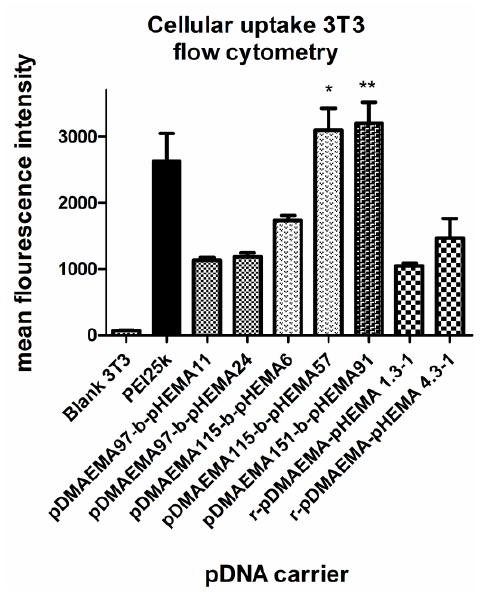
Figure 12. Cellular uptake of copolymer DNA-complexes with fluorescently labeled DNA, significance of *p < 0.05 and **p < 0.01 compared to PEI 25k according to the two-way